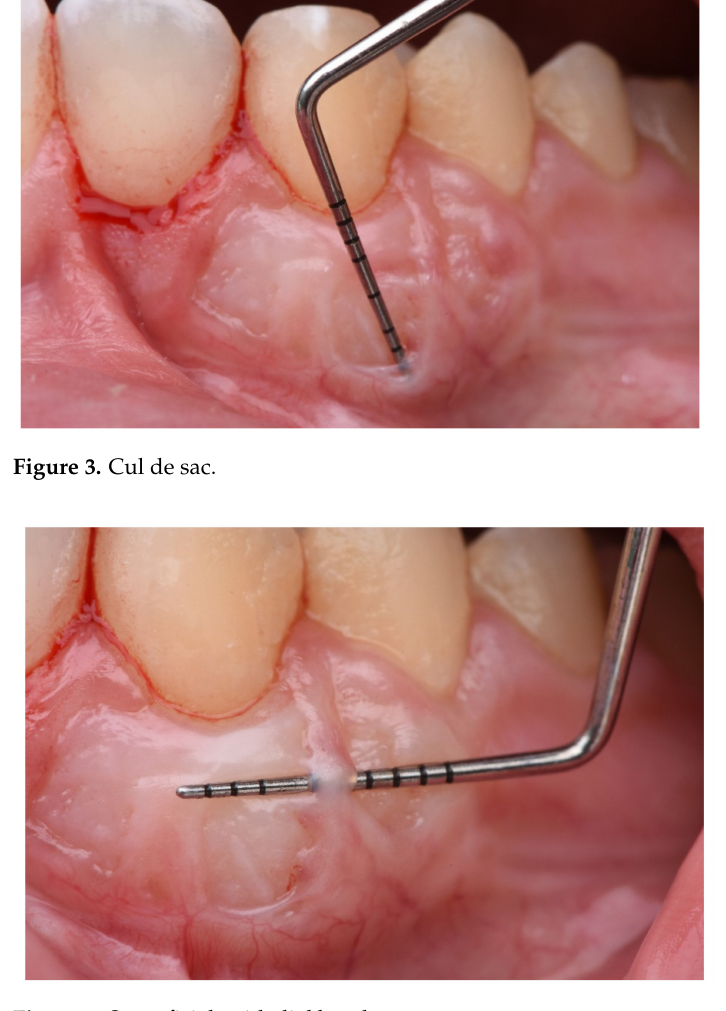
Figure 4. Superficial epithelial